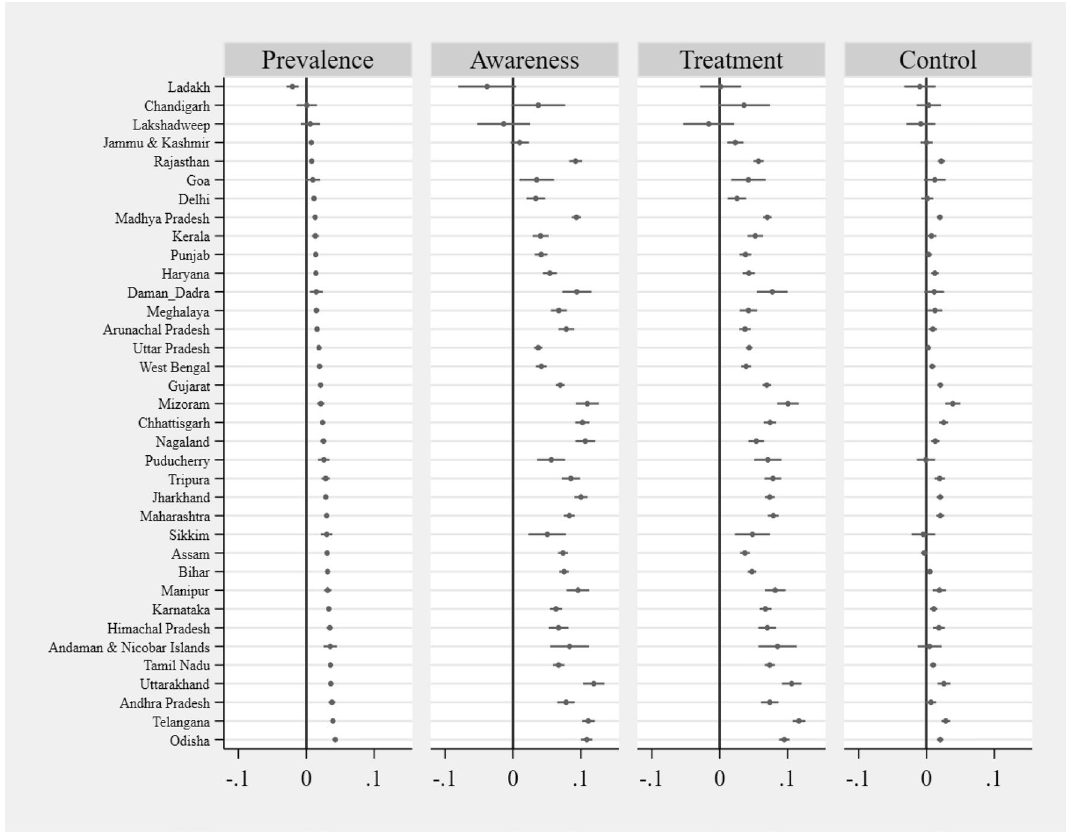
Figure 6. Adjusted concentration indices for diabetes and for ATC among persons who have the disease by states in India, 2019–2021 (see Supplementary Table S3).